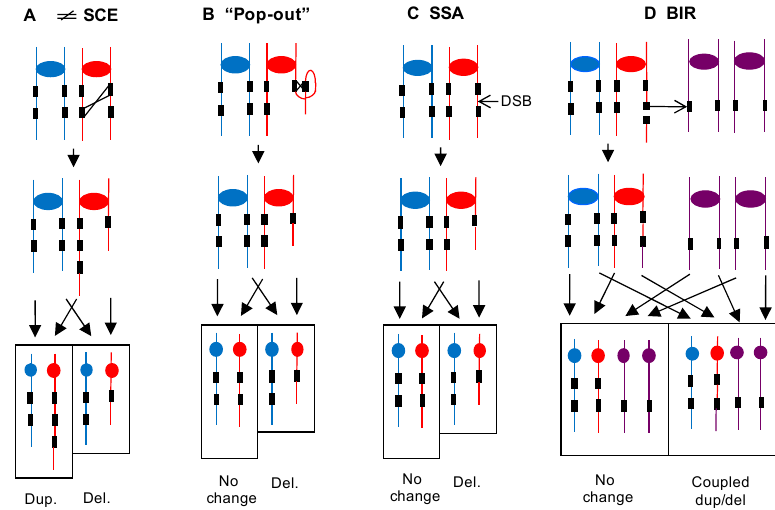
Figure 6. Homologous recombination between non-allelic repeats as a mechanism for generating large deletions and duplications. Blue and red lines show the two homologs of the diploid, and the purple lines indicate a different homolog. Black rectangles depict directly repeated genes. Arrows near the bottom of each panel show patterns of segregation with rectangles outlining the two daughter cells. Duplicated and unduplicated centromeres are shown as ovals and circles, respectively. ( A ) Unequal sister-chromatid exchange. Unequal crossing over between non-allelic repeats will produce one chromosome with a deletion and one with a duplication. Such unequal crossovers could also occur between homologs. ( B ) “Pop-out” event. An intrachromatid crossover between direct repeats will produce a chromosome with a deletion and a circular DNA molecule. The circle would likely be lost because it lacks a centromere. ( C ) Single-strand annealing (SSA). In this mechanism, a DSB occurs between two directly oriented repeats. Following processing of the broken ends, the repeats can anneal, resulting in loss of one repeat and the intervening DNA sequences [22]. ( D ) BIR. A DSB occurs in a repeat in one of the red chromatids with loss of the terminal fragment. The centromere-containing broken end invades a repeat on a non-homolog (purple chromatids) and copies the sequences from the point of invasion to the chromosome terminus. The resulting event generates a translocation. The daughter cell with the translocation will contain a large terminal deletion of “red” sequences and a large terminal duplication of “purple” sequences.